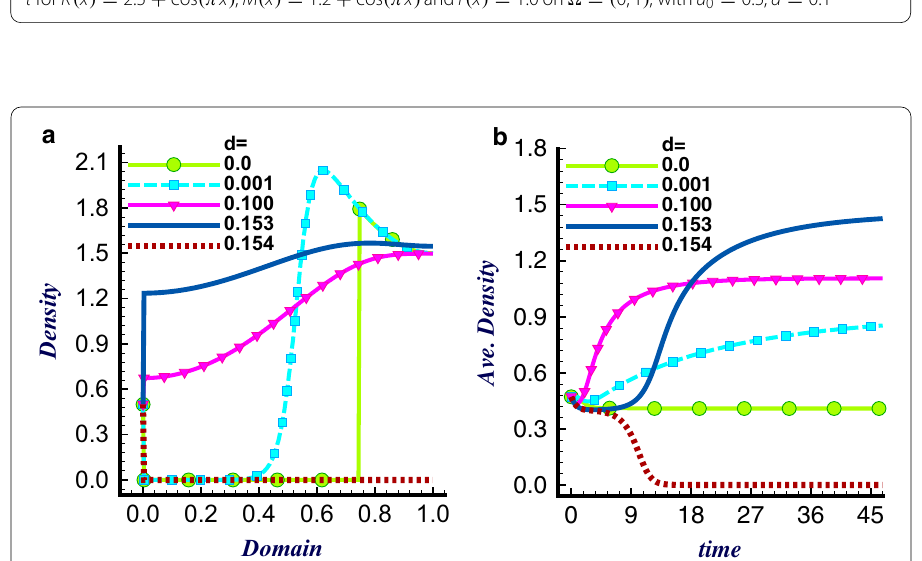
50 in ( a ) and average = 1.0 on � ( 0,1 ) , with = =